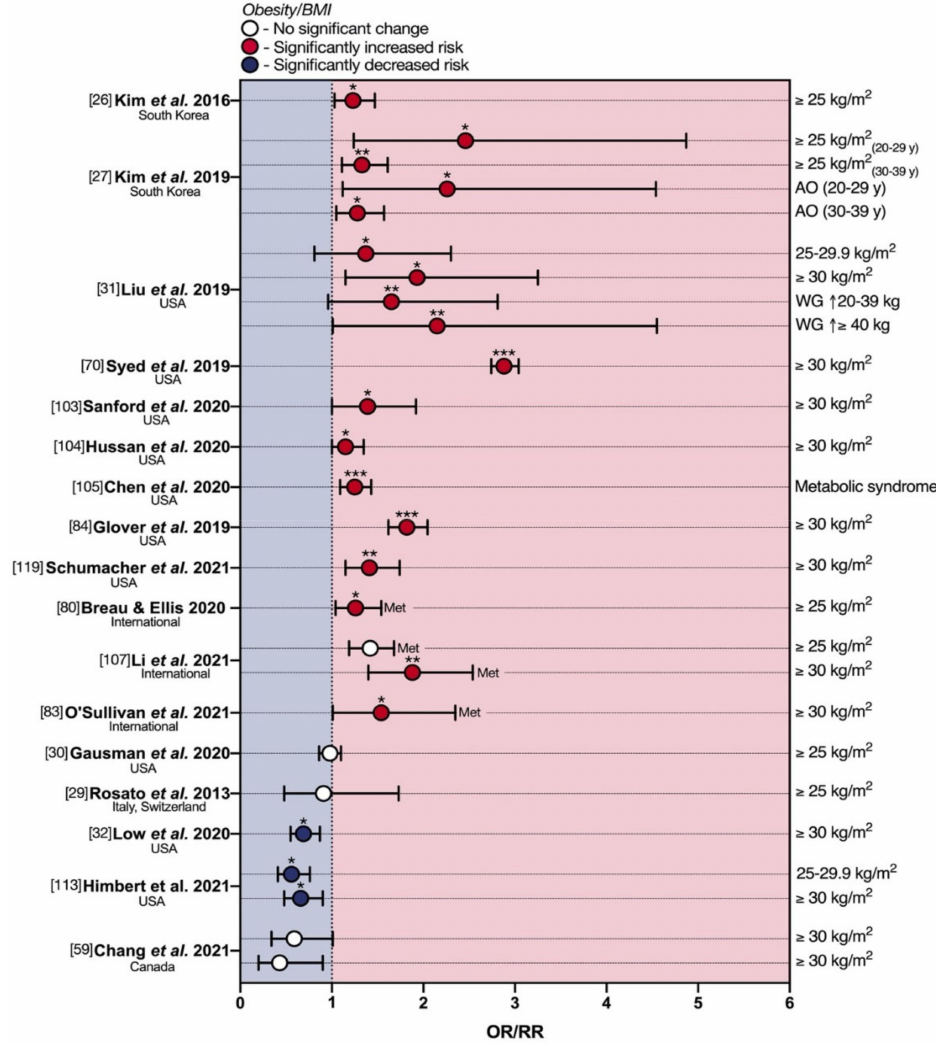
Figure 5. Protective and deleterious effects of obesity in early-onset colorectal cancer. AO—abdominal obesity; BMI—Body mass index; eoCRC—early-onset colorectal cancer; Met—meta-analysis; OR—odds ratio; RR—relative risk; SSB—sugar- sweetened beverage; WG—weight gain. * p < 0.05; ** p < 0.01; *** p <